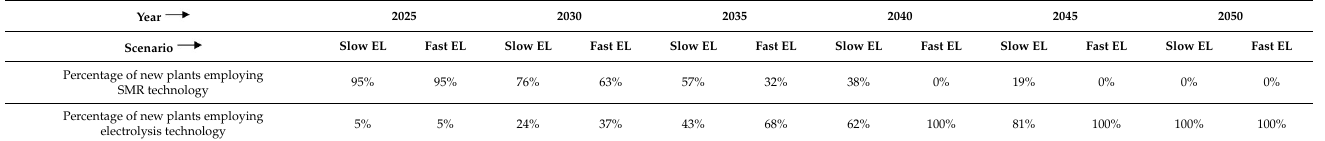
Table 3. Scenarios considered for hydrogen production plant